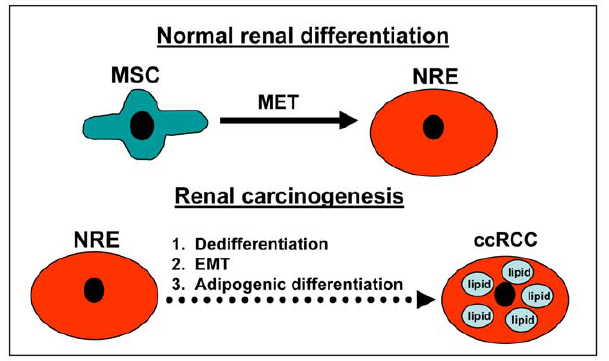
Figure 8. Proposed model for cellular differentiation in ccRCC. During normal renal development, mesenchymal stem cells undergo mesenchymal epithelial transition (MET) to develop into normal renal epithelial cells (NREs). In renal carcinogenesis, NREs undergo de- differentiation and epithelial mesenchymal transition (EMT), followed by adipogenic differentiation to develop into ccRCC.